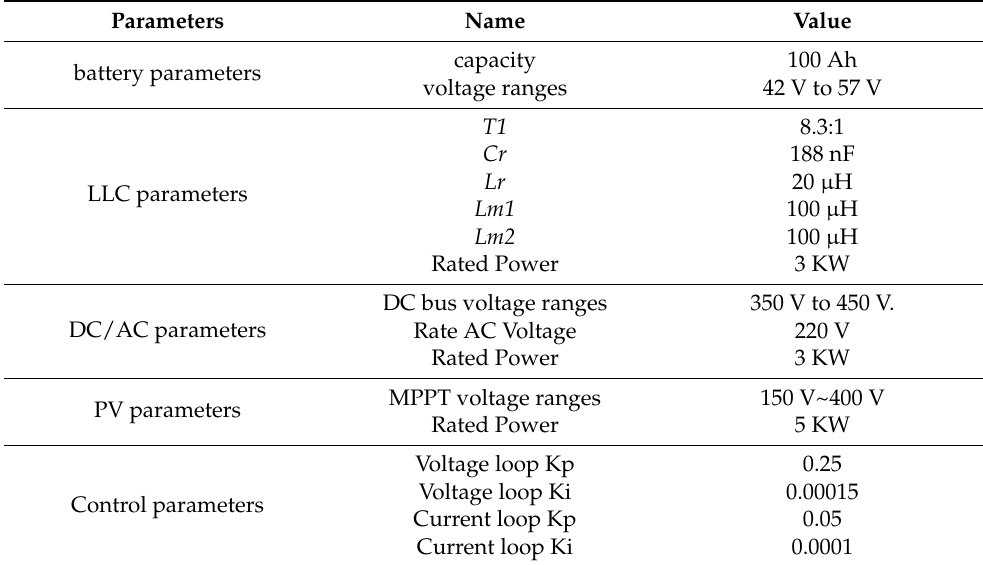
Table 1. Experiment platform parameters and control-loop parameters.